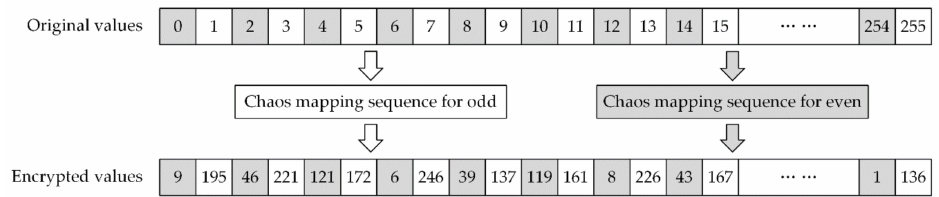
Figure 6. Example of pixel encryption.